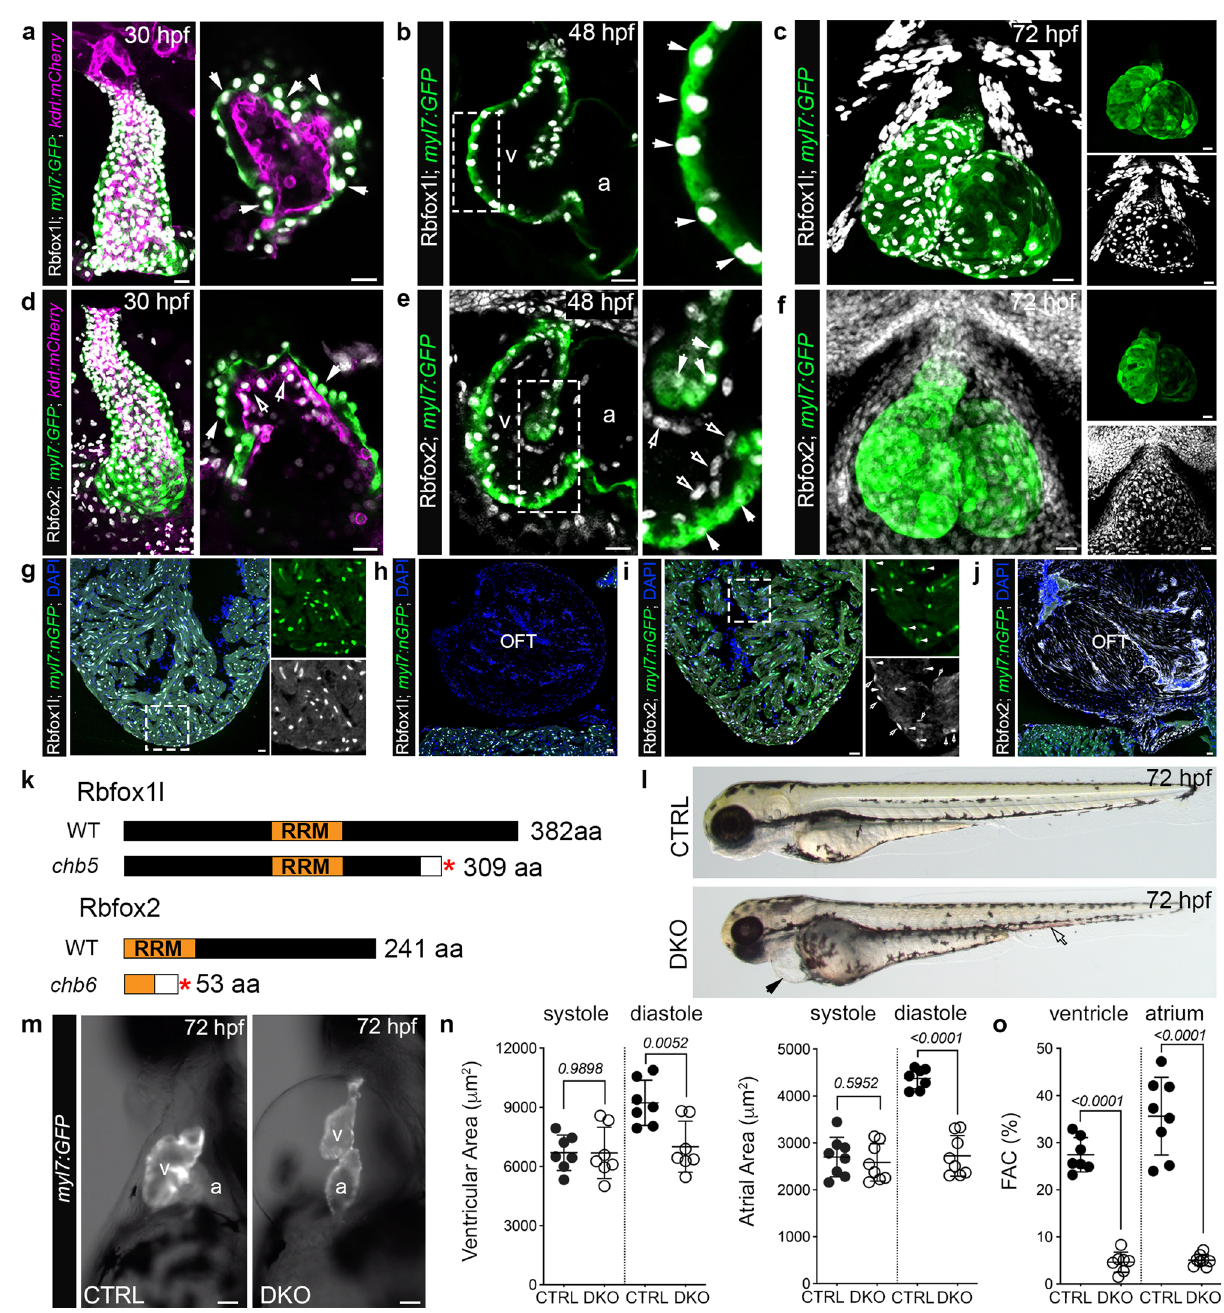
Fig. 1 | Rbfox1l and Rbfox2 function redundantly to support cardiovascular development in zebra fi sh. a – f Confocalz-stacks and single opticalsectionsof 30, 48, and 72hpf hearts from Tg(myl7:GFP);Tg(kdrl:mCherry) zebra fi sh following immunostaining forGFP, mCherry, Rbfox1l,and Rbfox2as indicated. Whitearrows show Rbfox1l or Rbfox2 within cardiomyocytes. Open arrows show Rbfox2 in endocardial cells. Boxed regions are shown at higher magni fi cation. Split channels of ( c ) and ( f ) are shown. g – j Merged confocal images of cardiac sections from Tg(myl7:nGFP) adult zebra fi sh following immunostaining for GFP, Rbfox1l, and Rbfox2 and counterstained with DAPI. Boxed regions in g and i are shown as split channels. White arrowheads show Rbfox2 in cardiomyocytes. Open arrowheads show Rbfox2inpresumptiveendocardialcells. k DiagramsofwildtypeRbfox1land Rbfox2 and the predicted protein products of the rbfox1l chb5 and rbfox2 chb6 . Red asterisks mark the locations of premature stop codons. White boxes indicate